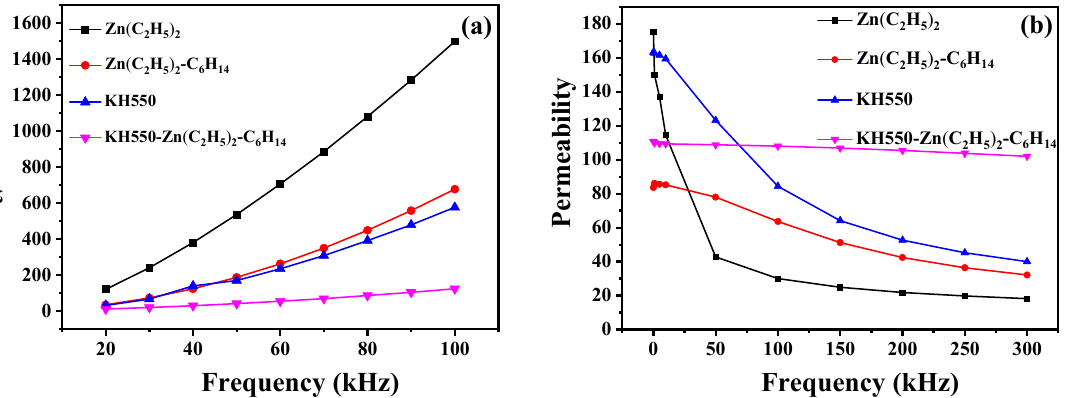
Figure 3. ( a ) Core loss and ( b ) effective permeability of the coated Fe-based magnetic ring prepared with different surface treatments.